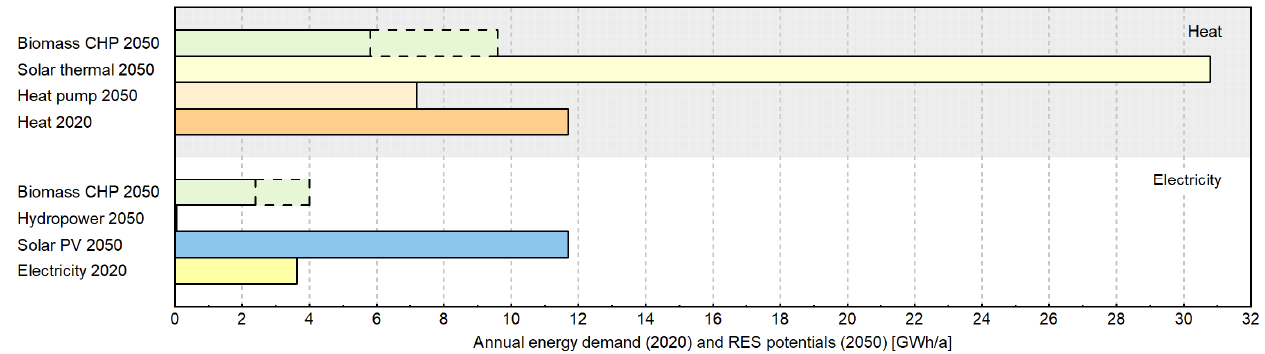
Figure 6. Decentral realizable heat and electricity potentials regarding RECs in the year 2050 compared with the current annual heat and electricity demand in St. Margareten im Rosental.